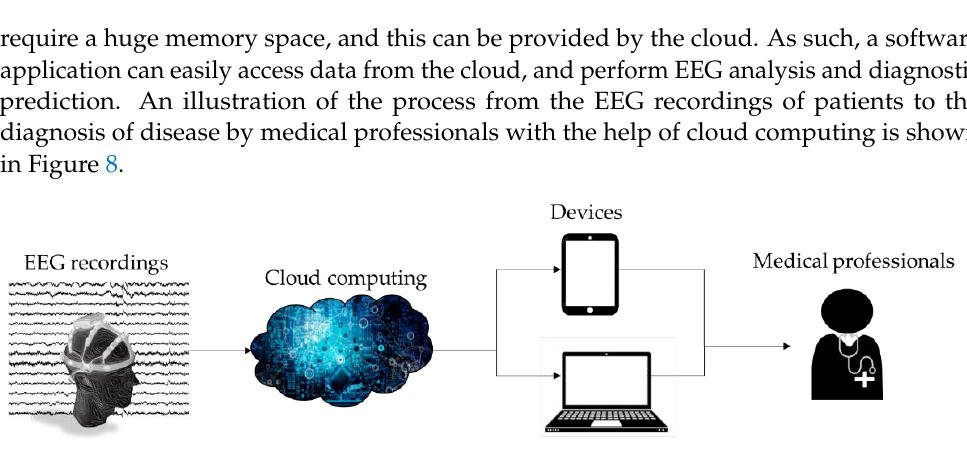
Figure 8. Workflow of cloud-based system to assist medical professionals to automatically detect PD using EEG record- ings.